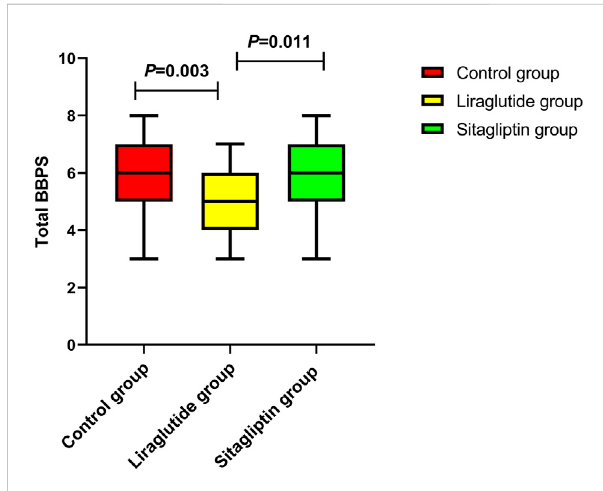
FIGURE 4 The distribution of BBPS in T2DM with DPN among the three groups.